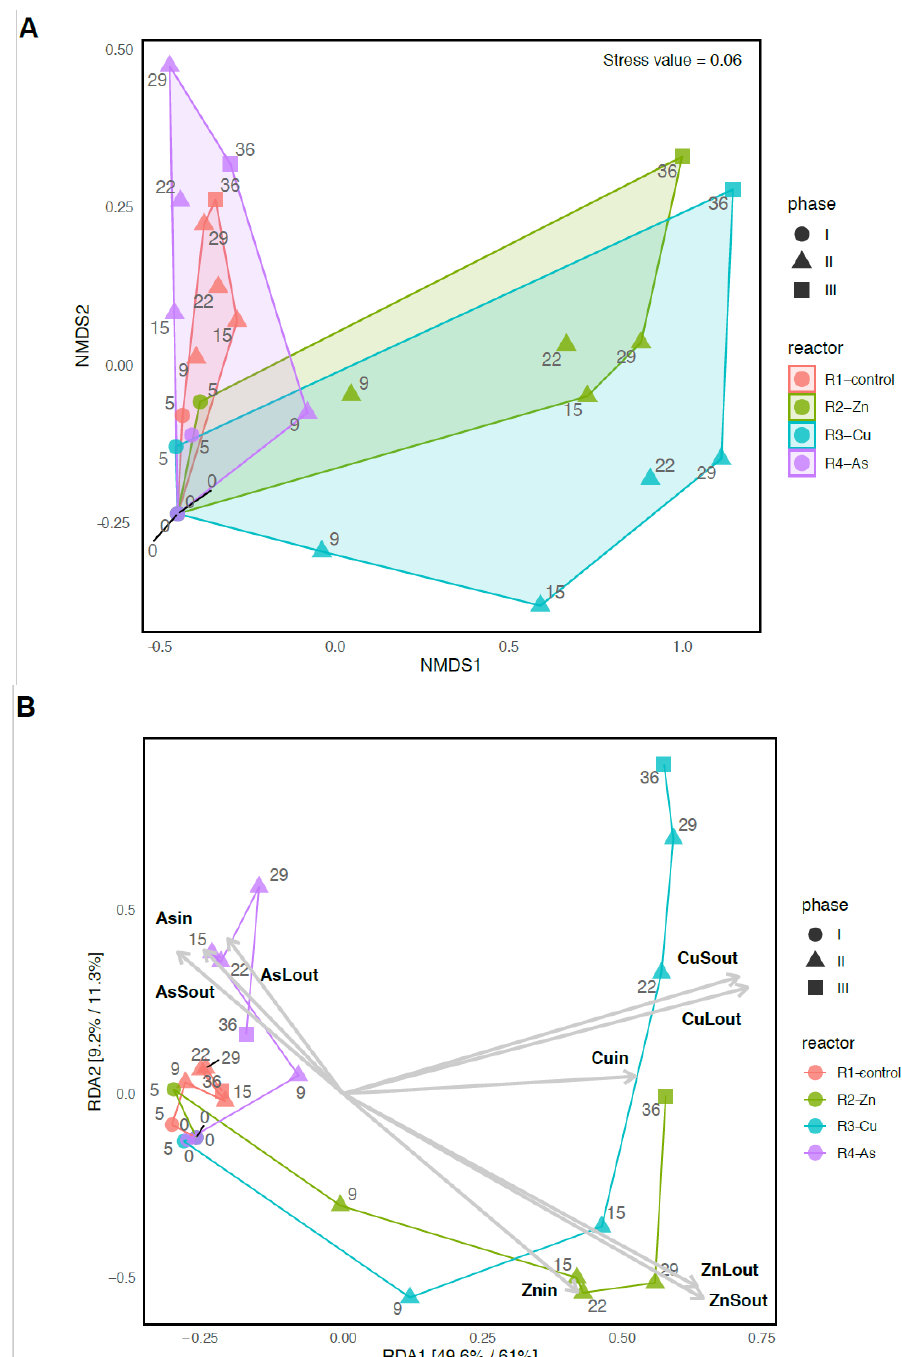
Figure 3. Variation in community composition among PBRs and over time. Non-Metric Multidi- mensional Scaling Analysis (NMDS) based on the Bray – Curtis distance measure. Prior to the analysis, bacterial species that are not present in more than 0.1% relative abundance in any sample were removed ( A ). Transformed-based redundancy analysis. Total and constrained variance explained by each axis are indicated between brackets. Samples from the same reactor are connected with lines that indicate the temporal change. Operational variables that constrain the ordination are shown with grey vectors. Constrained variables are the concentration of the following: Znin — feed Zn, ZnLout — effluent liquid phase Zn, ZnSout — biomass Zn, Cuin — feed Cu, CuLout — effluent liquid phase Cu, CuSout — biomass Cu, Asin — feed As, AsLout — effluent liquid phase As, AsSout — biomass As ( B ).